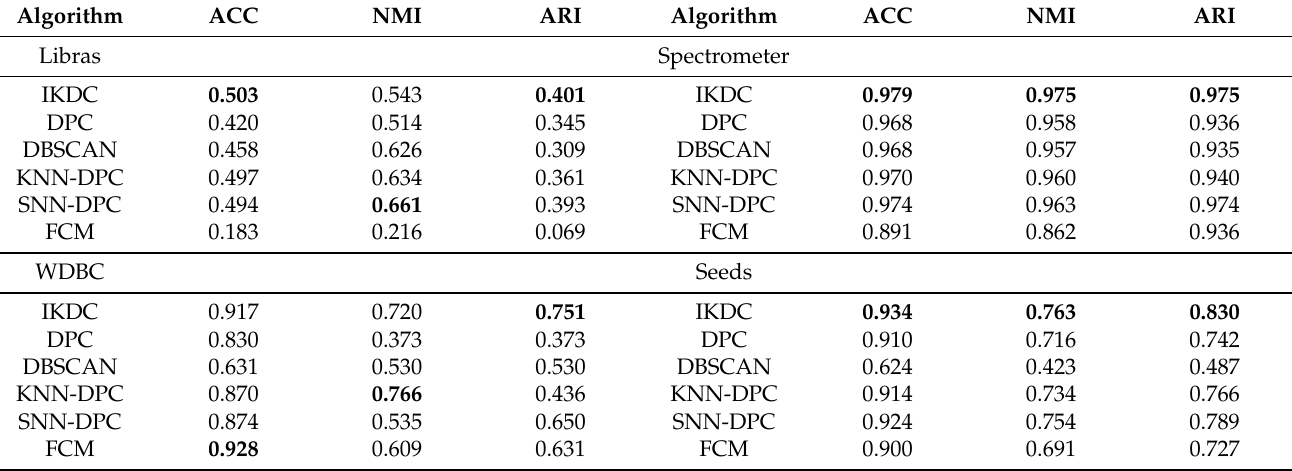
Table 7. ACC, NMI, and ARI of different clustering algorithms on different real